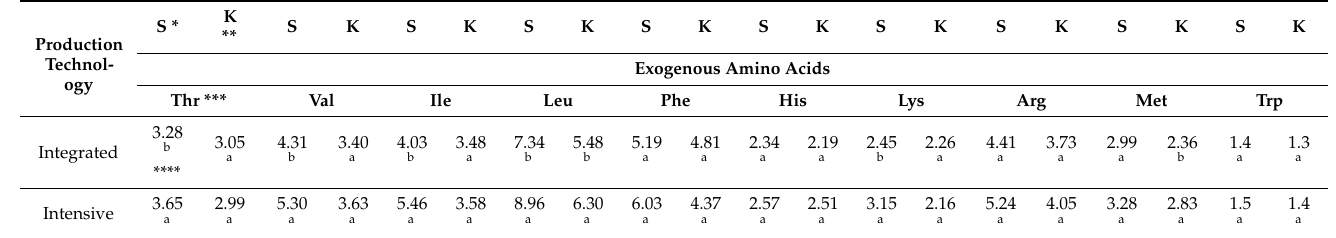
Table 2. Effect of production technology on the content of exogenous amino acids (g kg − 1 ) in durum wheat and common wheat